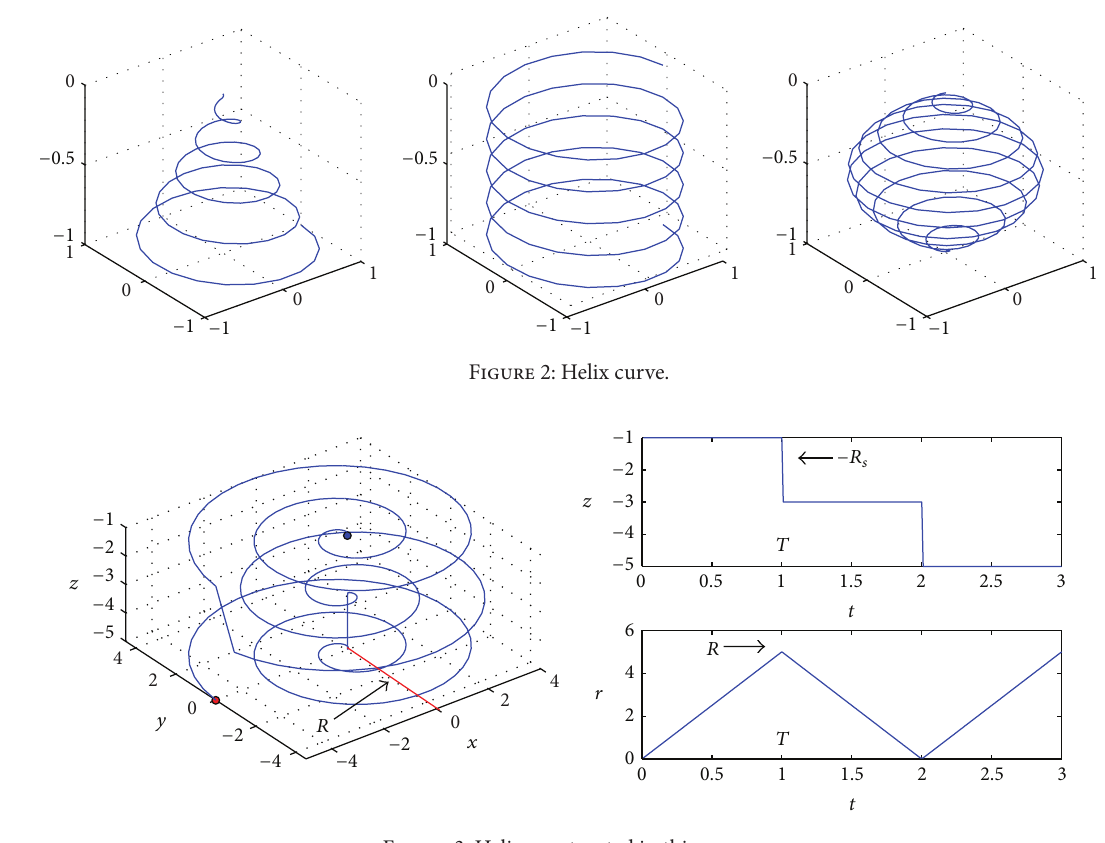
Figure 3: Helix constructed in this